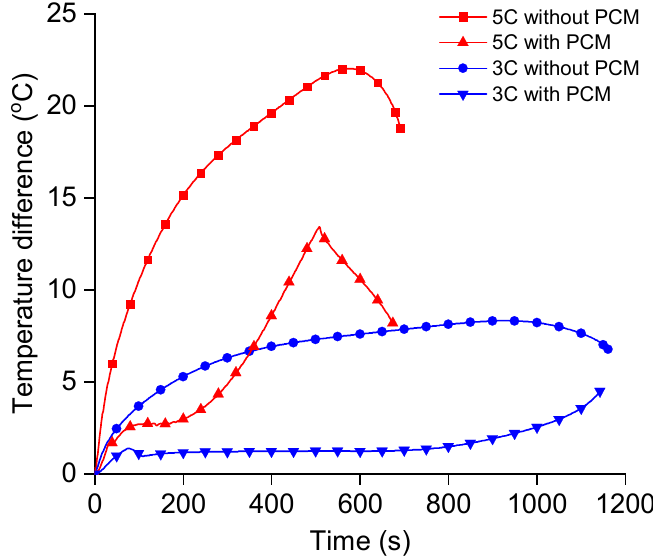
Figure 14. Investigation of temperature uniformity in the 3D Li-ion battery model. At the center plane of the cell, two monitoring lines were selected to explore the temperature change at z = 0.1245 m and y = 0.1135 m, as depicted in Figure 15a. Figure 15b shows the temperature along the vertical line at the end of discharging. There was a large difference of 15.5 ◦ C between the top and bottom positions under the 5C rate without a PCM. The use of PCM–MF caused a sudden change in temperature in the lower area of the cell at the 3C discharge rate, due to a liquid mushy PCM zone. It can be seen in Figure 15c that the temperature varied slightly in the horizontal direction and tended to be more stable when the PCM was applied. All of the differences were below 1 ◦ C. Because the heat source was concentrated in the region close to the current collecting tabs, the temperature variation was clearly greater in the vertical direction than in the horizontal direction.